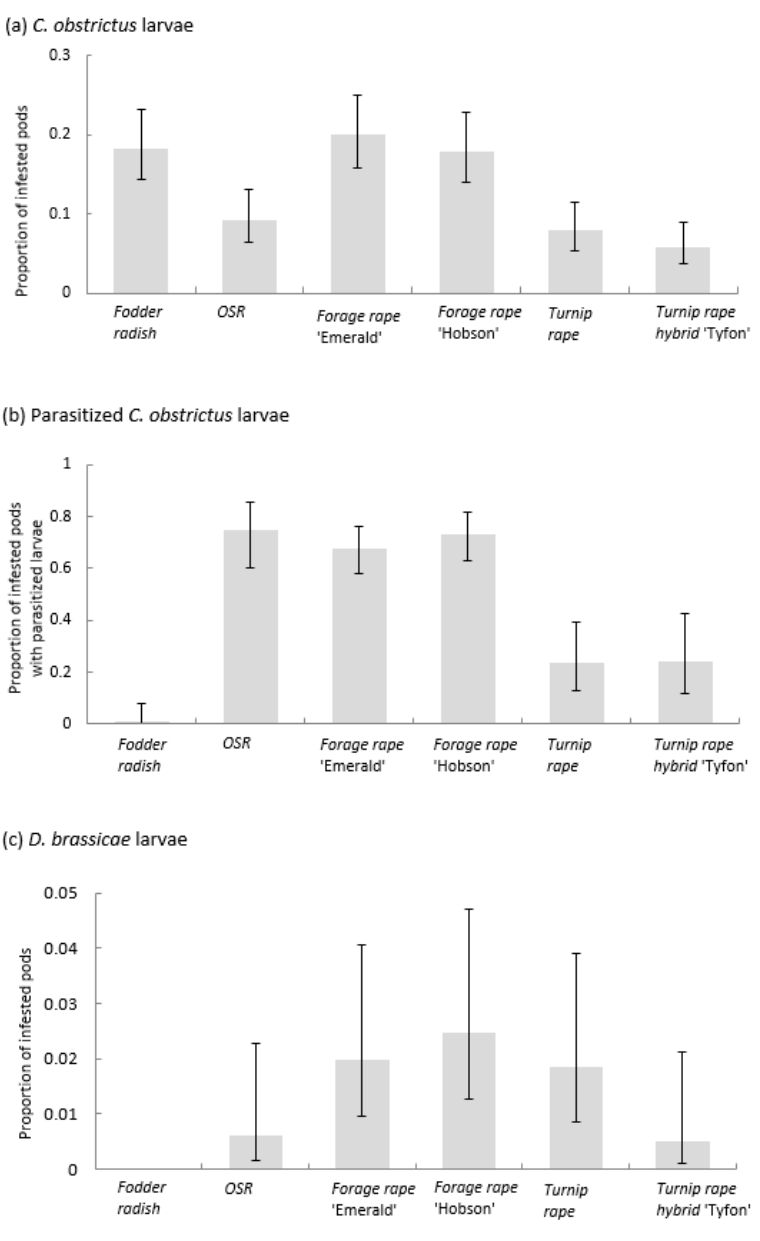
Figure 6. Proportion (back-transformed logistic regression predictions, ± CIs) of ( a ) pods infested by cabbage seed weevil ( Ceutorhynchus obstrictus ) larvae; ( b ) seed weevil-infested pods with parasitised larvae; ( c ) pods infested by brassica pod midge ( Daseneura brassicae ) larvae. Pods sampled from plots of different Brassicaceae: Fodder radish ( Raphanus sativus ) cv Apoll; Oilseed rape (OSR; Brassica napus ) cv Castille; Forage rape ( Brassica napus ) cv Emerald and cv Hobson; Turnip rape ( Brassica rapa ) cv Jupiter and Tyfon (a hybrid of B. rapa Rapifer group × B. rapa Pekinensis group). The proportions of pods infested by pod midge larvae differed amongst the brassicas (F 5,15 = 4.31, p = 0.012; Figure 6c). Infestation rates were similar in both forage rapes (‘Hobson’ and ‘Emerald’) and in B. rapa ‘Jupiter’ (2.5%, 2.0 and 1.8%, respectively) but infestation was lower on OSR (0.6%) and ‘Tyfon’ (0.5%). No infested fodder radish pods were